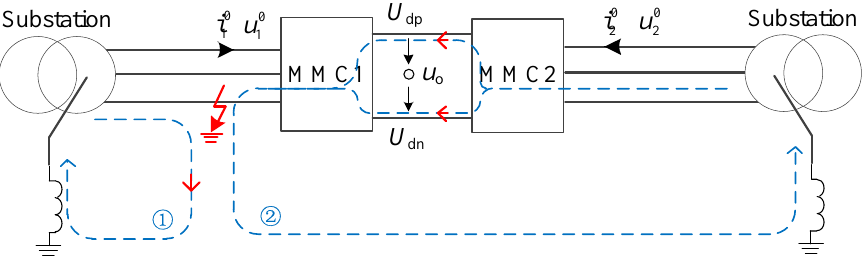
Figure 4. Zero-sequence current path.